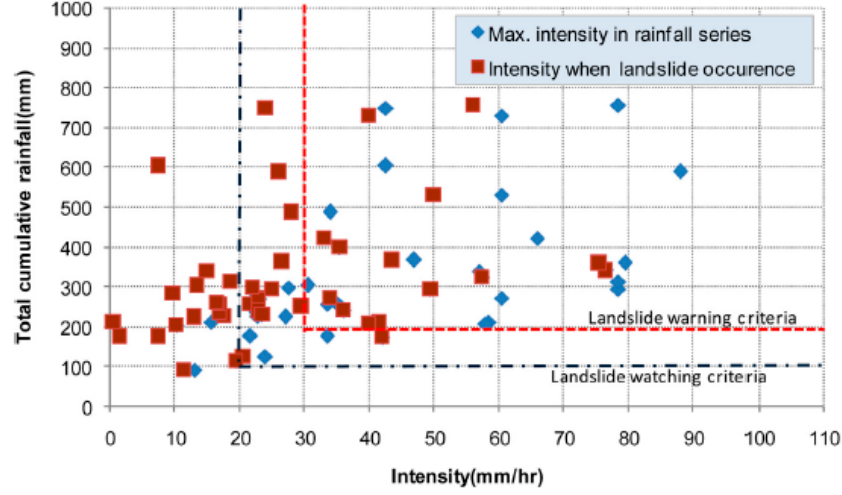
Figure 3. Accumulated rainfall and rainfall intensity at the time of debris flow occurrence